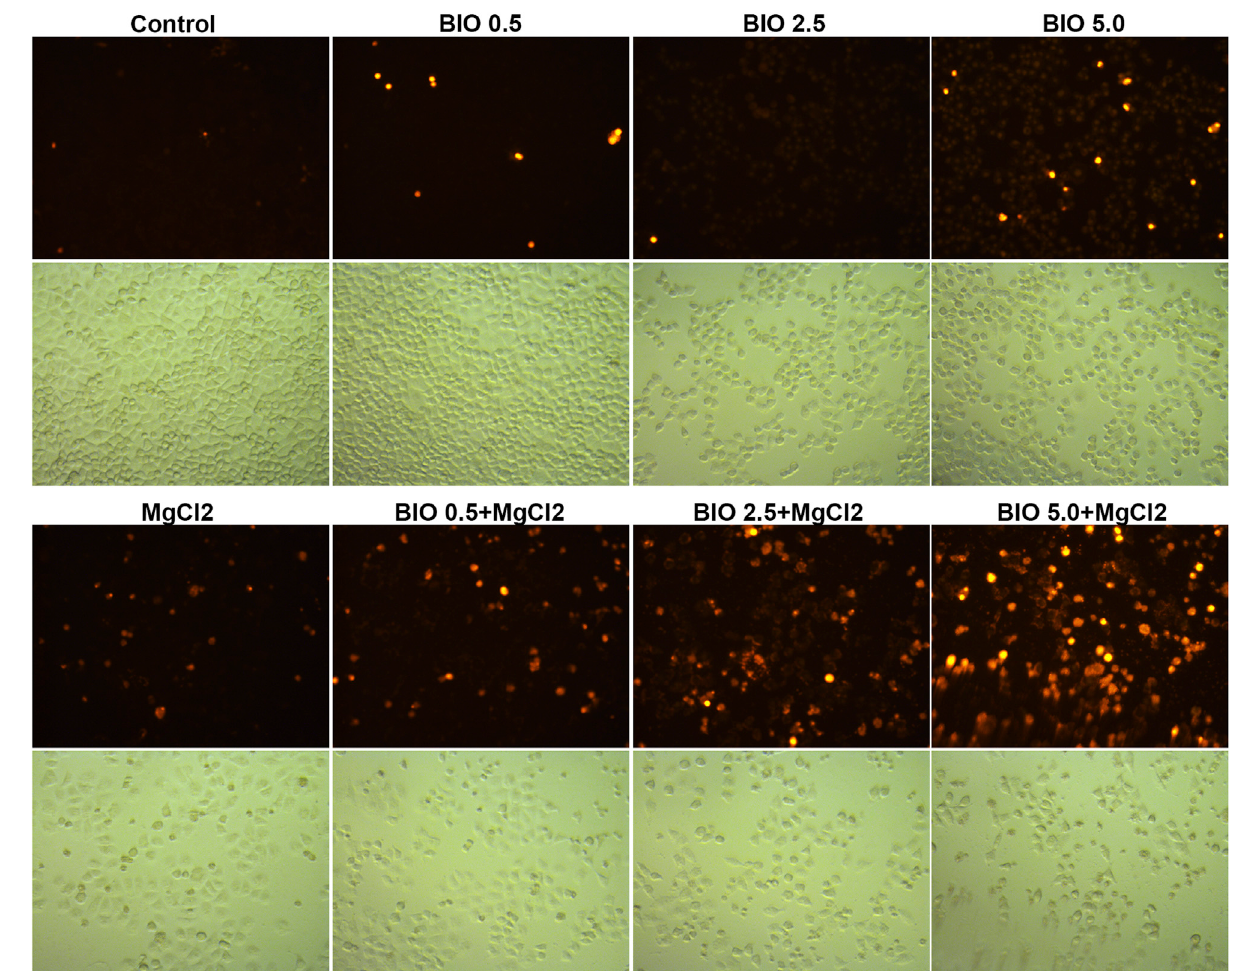
FIGURE7| DeterminationofcelldeathinMgCl 2 -treatedUC3bladdercancercellsincombinationwithdifferentconcentrationsofBIOtreatment via PIstaining.The immuno fl uorescence intensity of PI staining was showed in Supplementary Figure S14 .